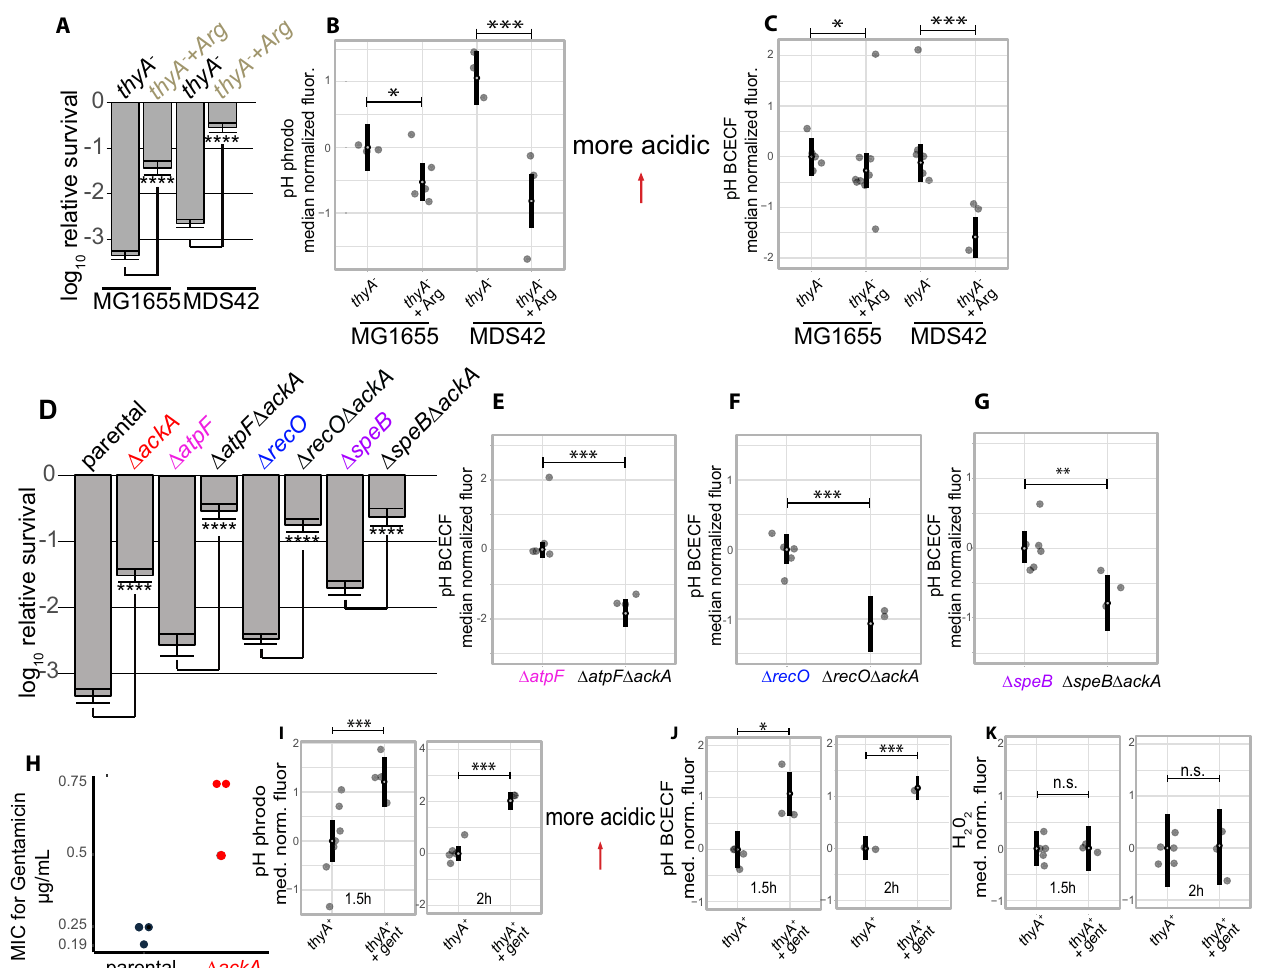
Fig 4. Experimental manipulation of pHi modulates survival. (A-C) Impact of arginine supplementation on survival and pHi. (A) L-arginine significantly increases the survival of thyA - strains in the MG1655 and MDS42 backgrounds at 3h thymidine starvation. (B-C) Fluorescence was measured for each independent experiment for strains stained for pHi at 3h thymidine starvation and measured using flow cytometry using pHrodo Green (B) and BCECF-AM (C). (D-G) Impact of ackA deletion on survival and pHi. (D) Deletion of ackA from various resistant mutants results in significant increases in survival at 3h thymidine starvation. (E-G) Adjusted fluorescence of strains stained for pHi at 3h thymidine starvation and measured using flow cytometry using BCECF-AM. (H) Minimum inhibitory concentration (MIC) of the thyA - and the Δ ackA strain for the antibiotic gentamicin. The concentrations are in μ g/mL. (I-J) Adjusted fluorescence of wild type ( thyA + ) cells stained for pHi at 1.5h with and without 1 μ g/mL gentamicin treatment and measured using flow cytometry using pHrodo Green (I) or BCECF-AM (J). (K) Adjusted fluorescence of wild type ( thyA + ) cells stained for ROS accumulation at 1.5h with and without 1 μ g/mL gentamicin treatment and measured using flow cytometry using Peroxy Orange. The p -values in (A) and (D) were calculated as for the death assays in the rest of this work, using a Welch t-test. See Fig 3 caption for definitions of plotted values and significance tests for flow cytometry data.